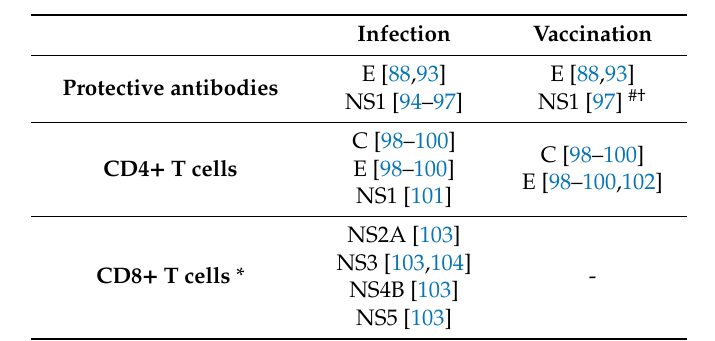
Table 2. TBEV proteins eliciting TBEV-specific immune responses in humans upon TBEV infection or TBEV vaccination.